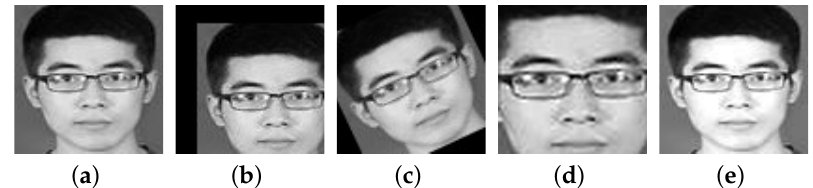
Figure 3. Geometric transformation and image brightness manipulation. ( a ) The original face image. ( b ) Result of image translation. ( c ) Result of image rotation. ( d ) Result of image zoom. ( e ) Result of changes of image